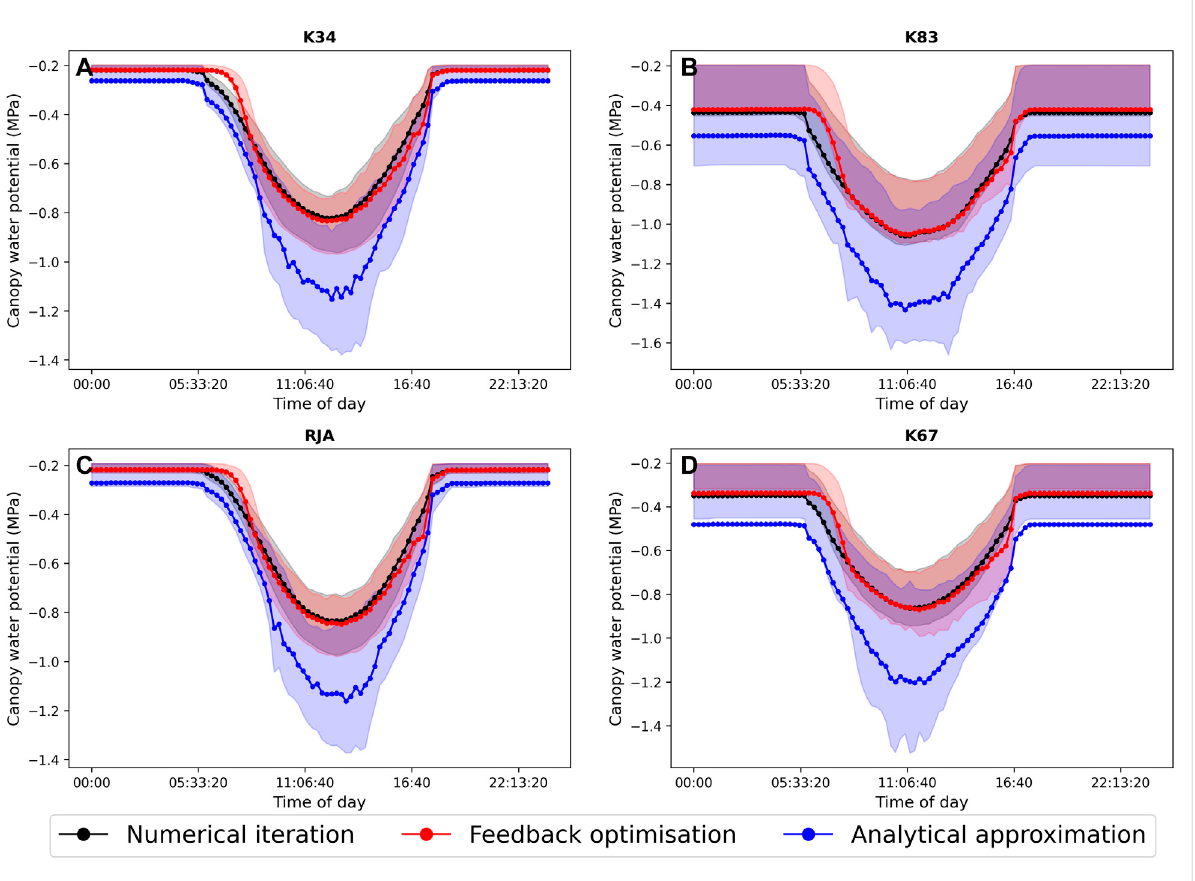
The average diurnal cycle of predicted canopy water potential (MPa) from JULES-SOX solved using three different methods (1. Numerical iteration (black), 2. Feedback control (red), 3. A semi-analytical approximation (blue)) at four sites in the Amazon rainforest. (A) LBA-K34 Reserva Cuieiras, Manaus Brazil; (B) LBA-K83 Tapajos National forest, Santarem Brazil; (C) LBA-RJA Reserva Jaru; (D) LBA-K67 Tapajos National forest, Santarem Brazil. Shaded areas represent the 25% and 75% uncertainty